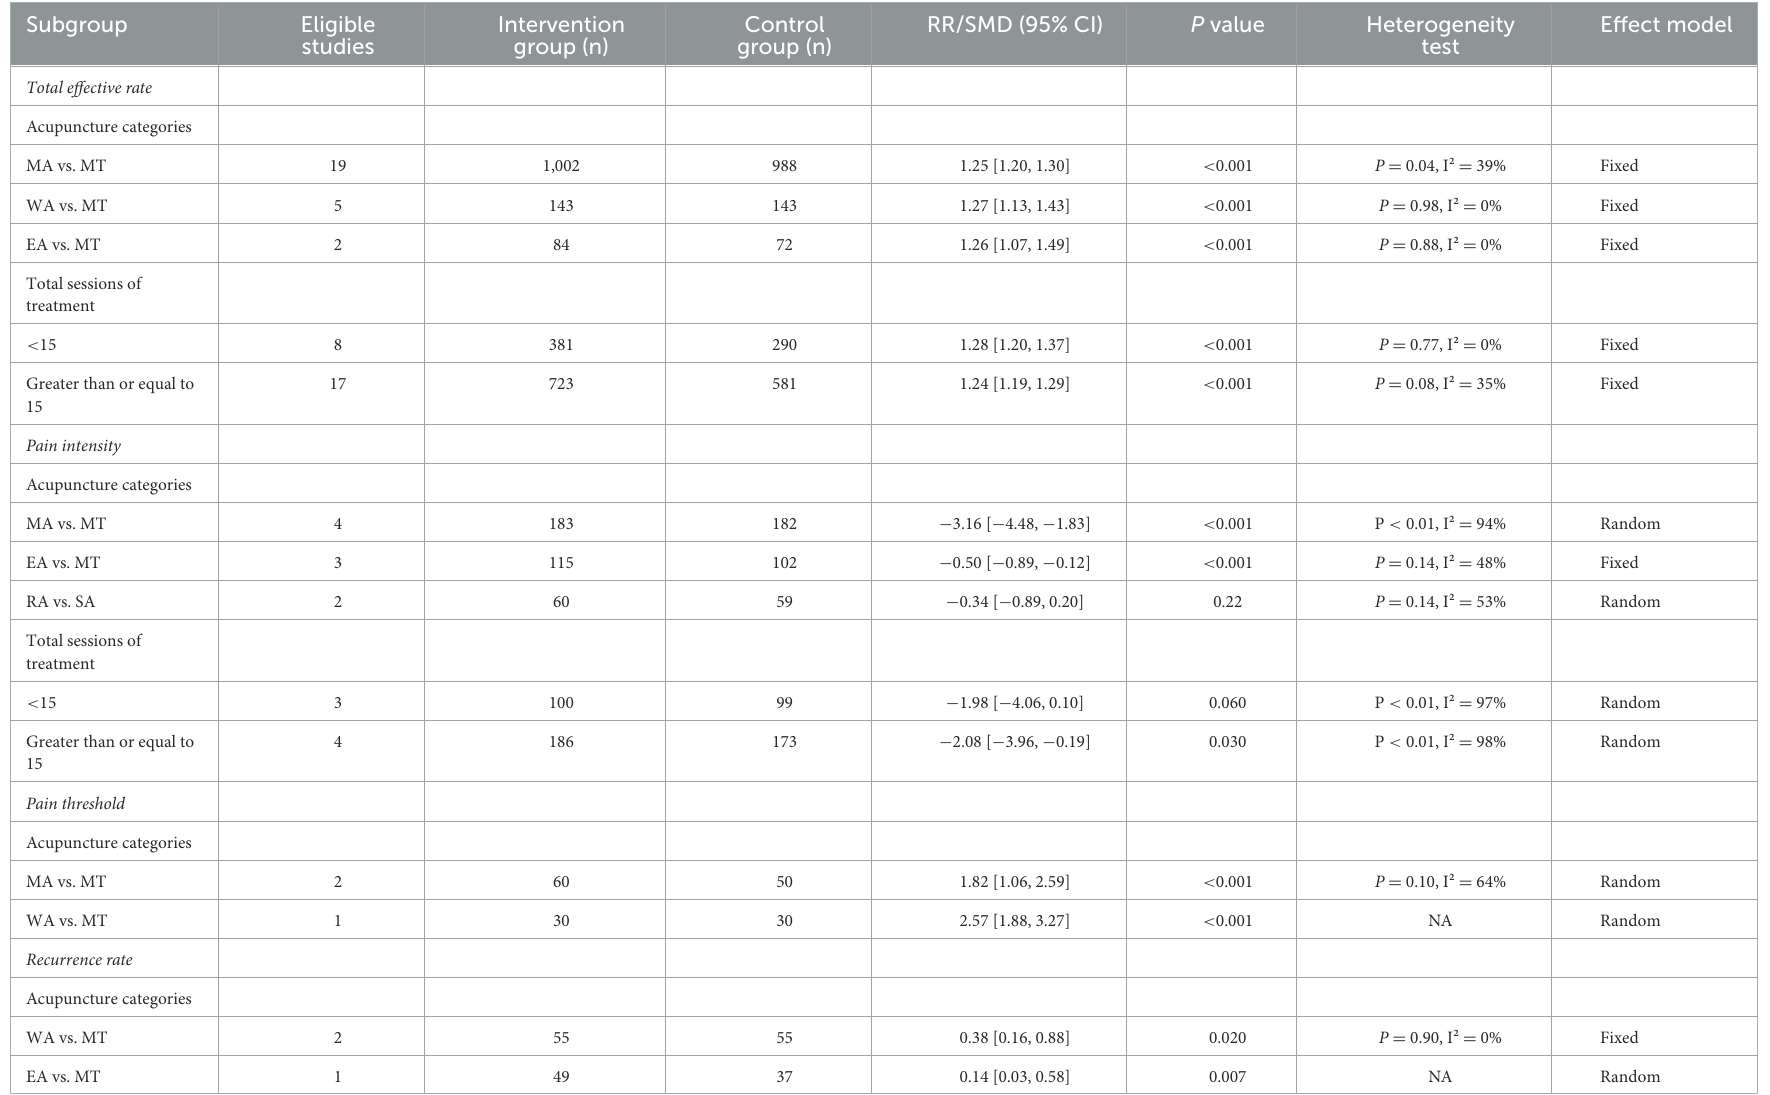
TABLE 3 The subgroup analysis for the outcomes of included studies. Subgroup Eligible